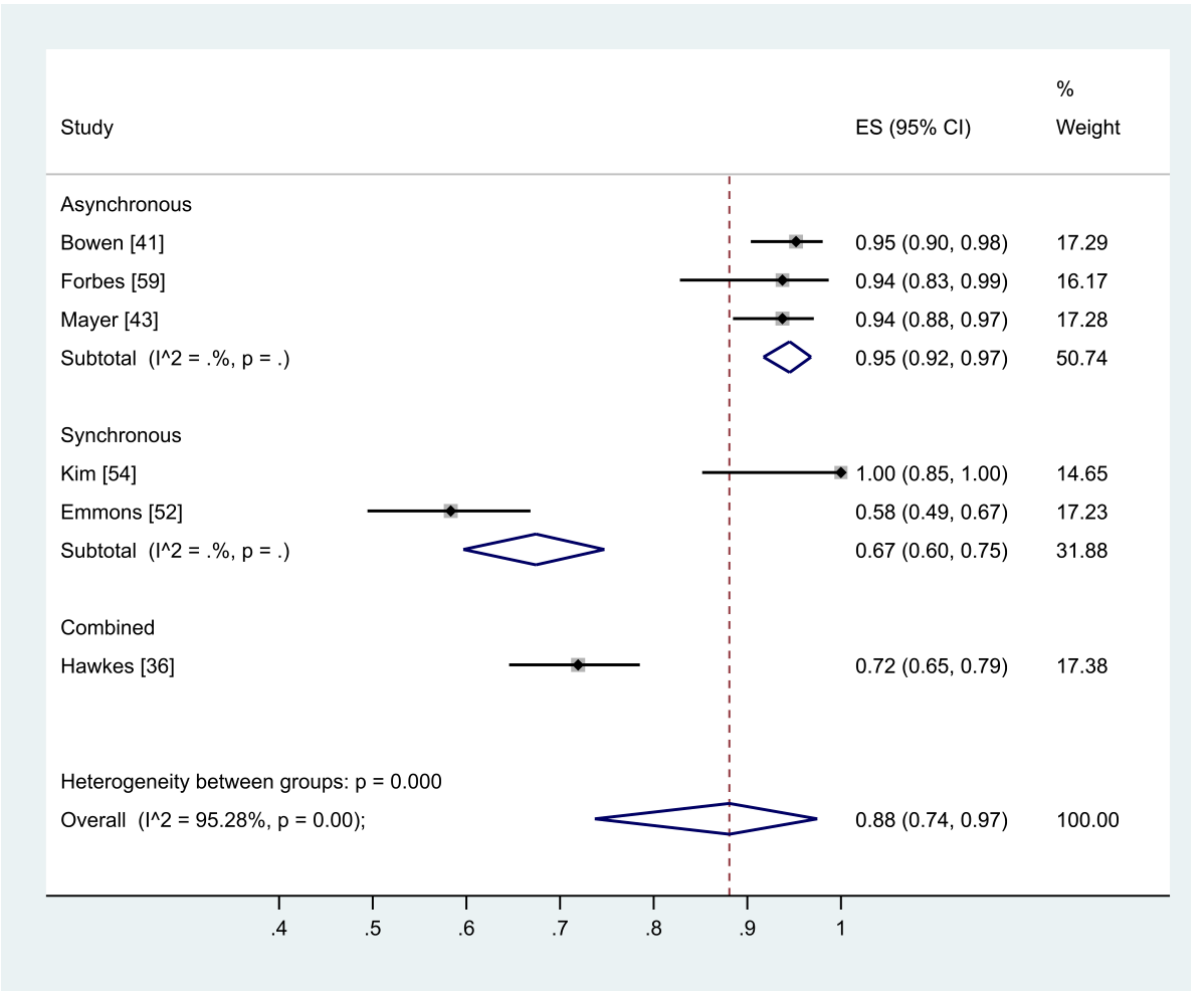
Figure 13. The effect of mode of delivery (synchronous or asynchronous) interventions on initiation engagement, analyzed using